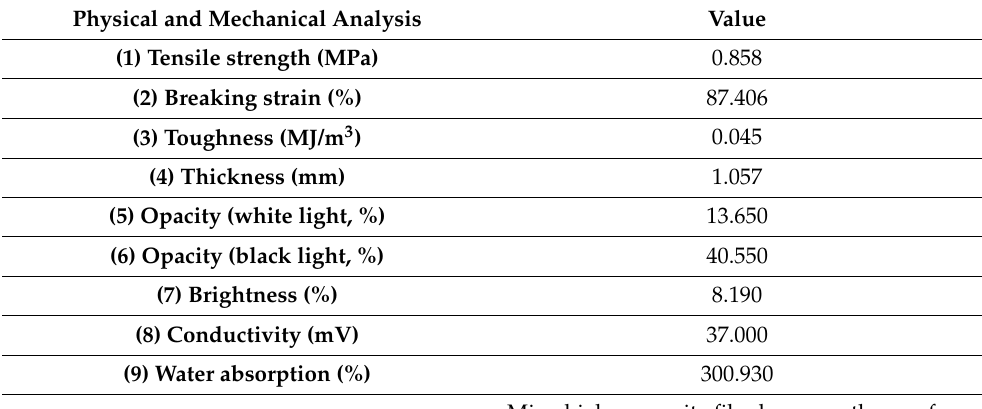
Table 3. Optimal conditions of 0.5 g microbial composite film for physical and mechanical properties. Physical and Mechanical